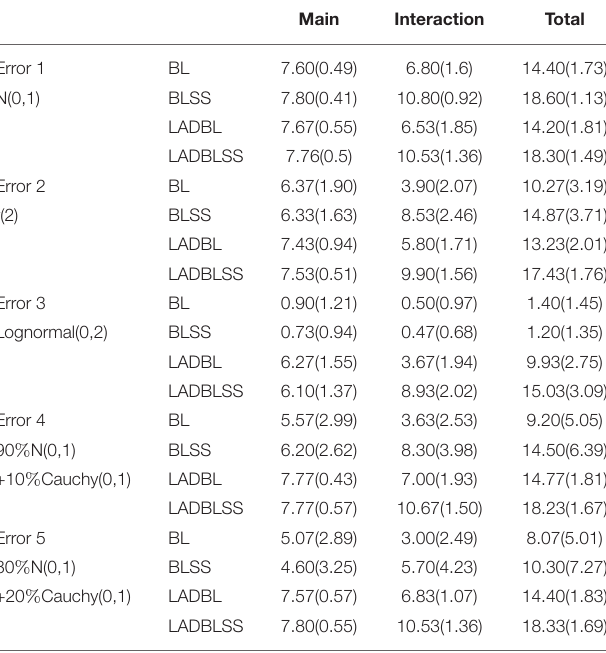
TABLE 2 | Identification results of the first setting with Top100 method for BL (Bayesian LASSO), BLSS (Bayesian LASSO with spike-and-slab priors), LADBL (LAD Bayesian LASSO) and LADBLSS (LAD Bayesian LASSO with spike-and-slab